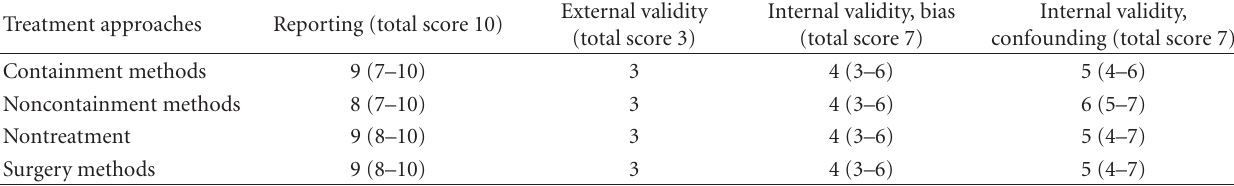
Table 2: The results of quality assessment of methodology of various research studies (total number of studies was 50).